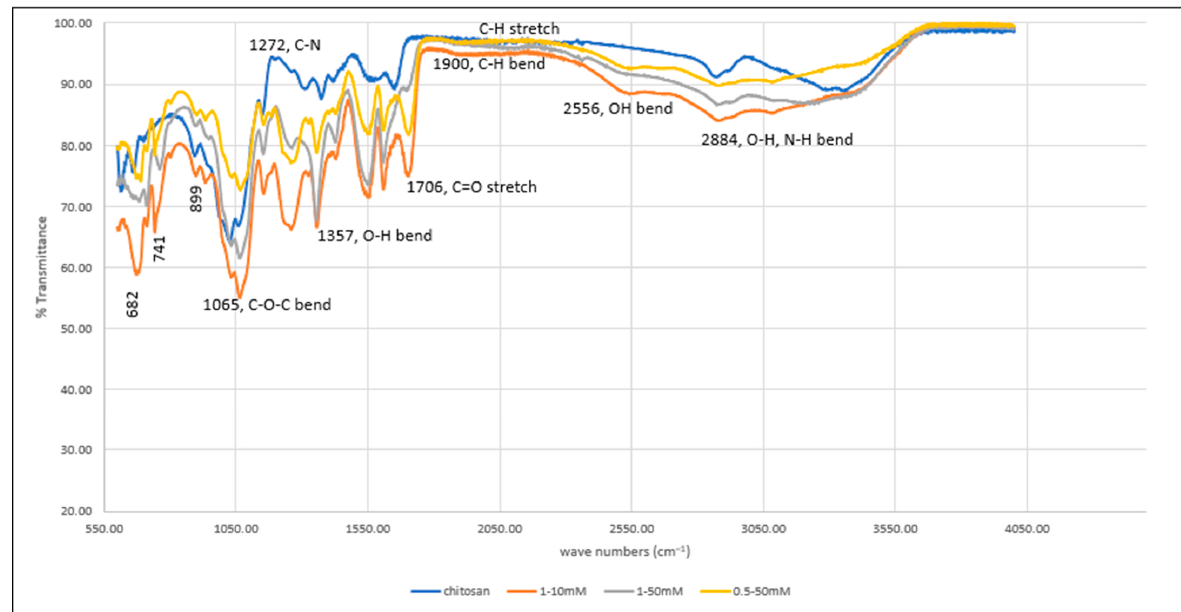
Figure 7. FTIR spectrum of uncross-linked and cross-linked chitosan hydrogel (in different concentrations).